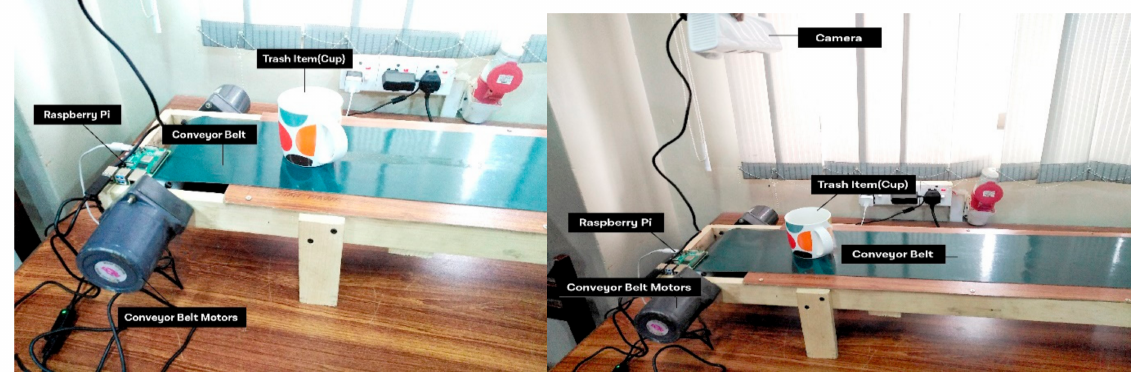
Figure 4. A real-time experimental view of classification cup.